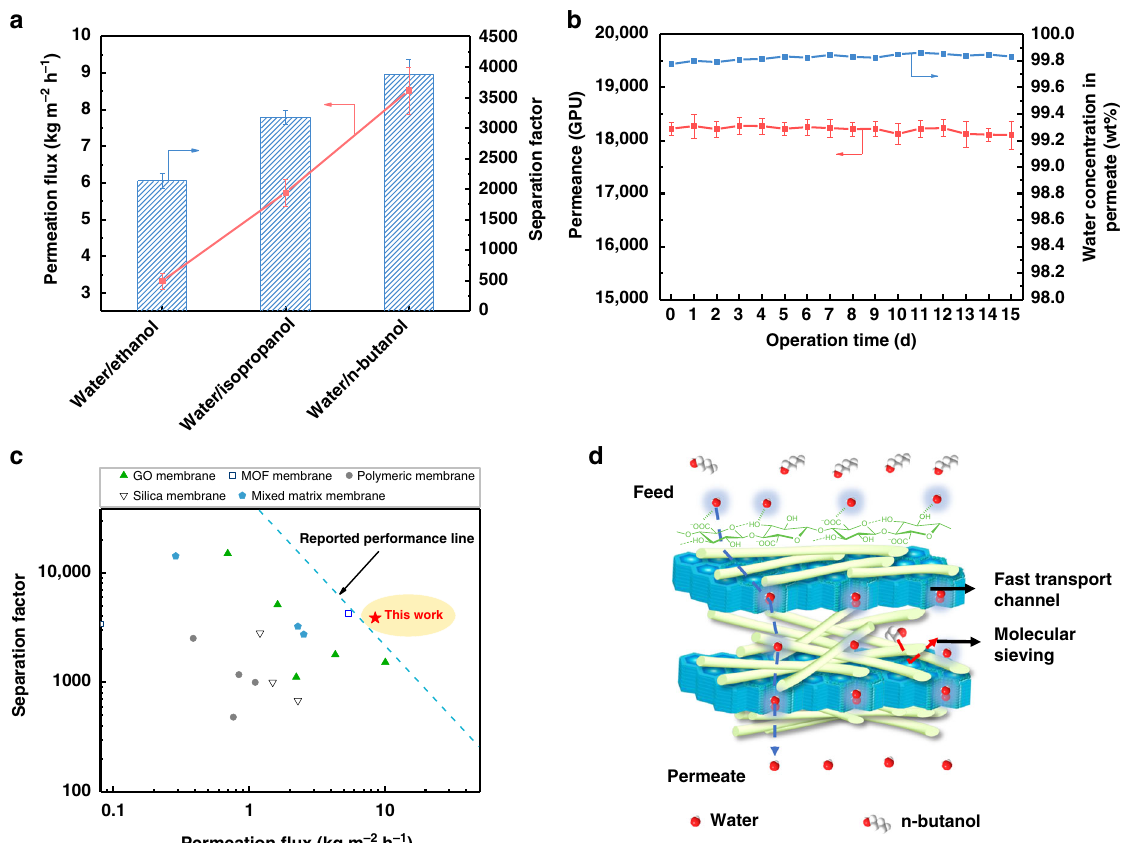
Fig. 4 Water-selective permeation properties of the membranes. a Separation performance of the TpTG Cl @CNFs-5/PAN membrane with respect to different water/alcohol systems (water concentration: 10 wt%). b Long-term separation performance of the membrane applied in a water/n-butanol system (water concentration: 10 wt%; operating temperature: 80 °C). c Comparison of the water/n-butanol separation performance of the TpTG Cl @CNFs- 5/PAN membrane and the representative membranes in the literatures. d A schematic diagram of the transport behavior of liquid molecules across the membrane. Error bars represent standard deviations for 3